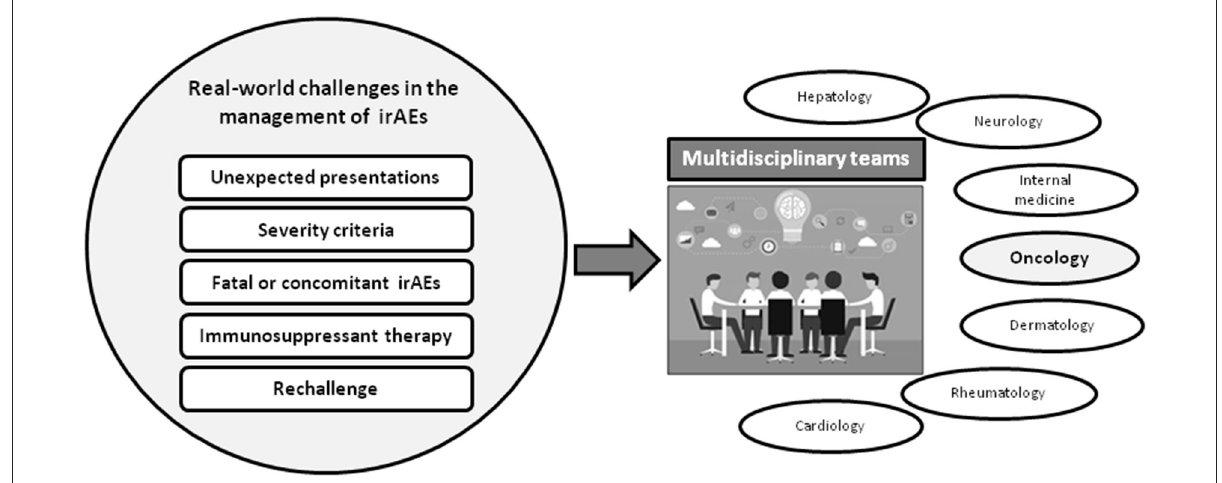
FIGURE1 Pitfalls of real-world practice immune-related adverse events associated with immune checkpoint inhibitors (ICIs) and need of multidisciplinary teams for their management. The difficulties and differences between irAEs reported at the clinical trials and real-world practice highlight the importance of the multidisciplinary management of patients with severe